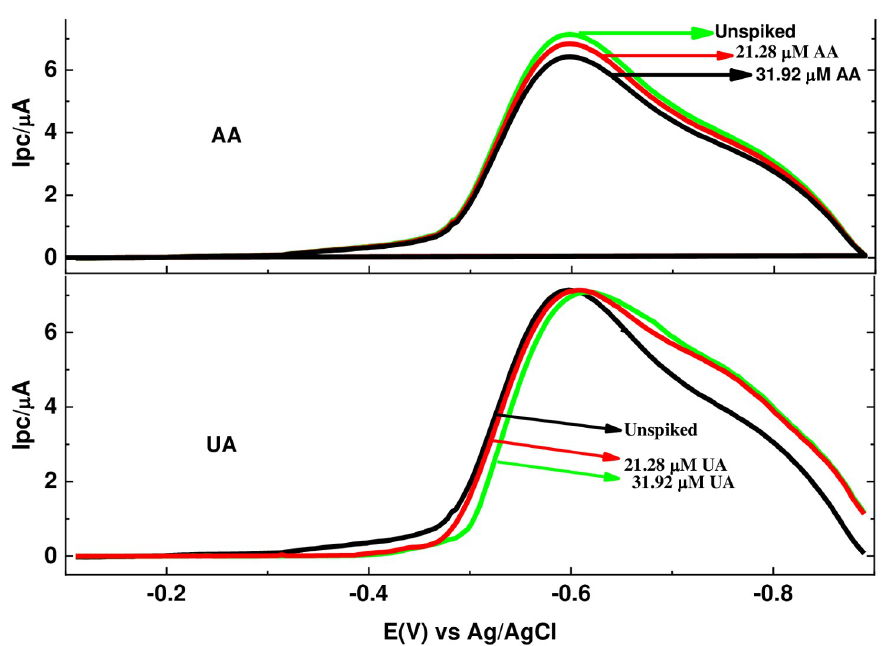
Fig 12. SWAdCSV of pH 7.0 PBS containing EPHARM MTZ tablet solution in the presence of various concentrations of UA and AA.